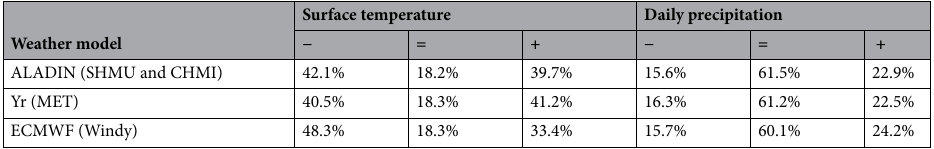
Table 4. Comparison of ratios that determine whether the models’ predictions are overvalued or undervalued. Note: sign + represents overvaluing,- undervaluing, and = correct